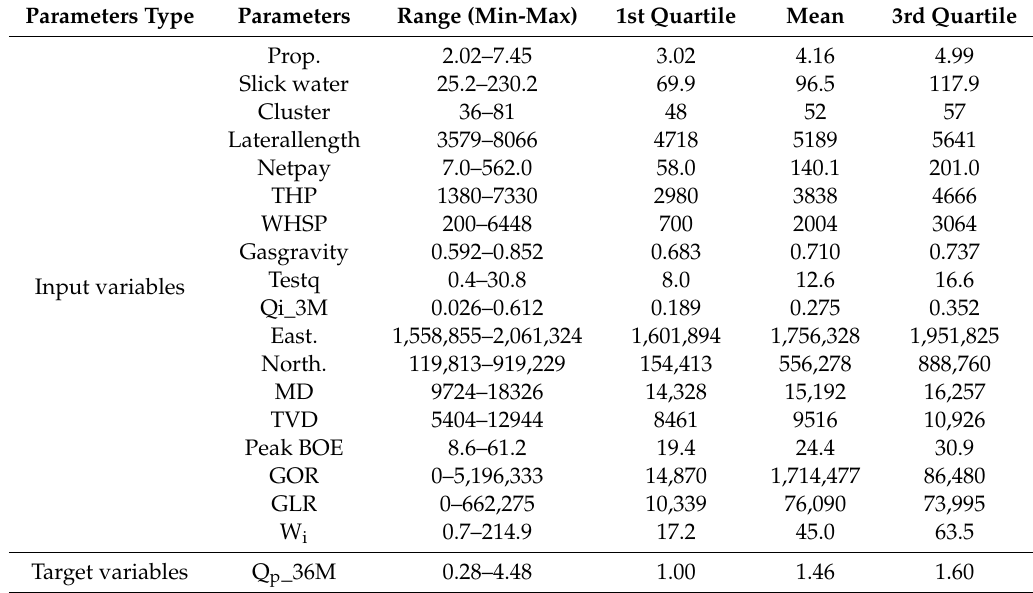
Table 2. Statistical analysis of input and target variables datasets used in this